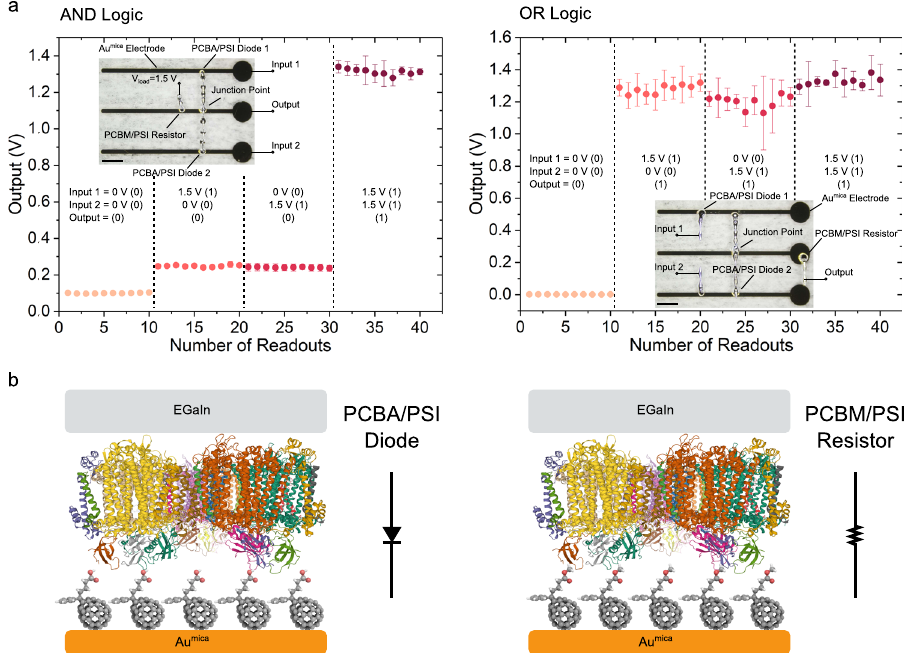
Fig. 5 Characterization of the functions of logic circuits comprising Au mica /PCBA//PSI//EGaIn junctions and Au mica /PCBM//PSI//EGaIn junctions and printed EGaIn electrodes. a Schematics (inset) and plots of output voltage of AND logic circuits (top) versus varied input under a constant load of 1.5 V and OR logic circuits (bottom) versus varied input. Numbers in brackets represent the input and output values in a truth table. Error bars represent standard deviation of the mean. Scale bars of the insets are 1.5 mm. b Schematics of the diode (left) comprising a Au mica /PCBA//PSI//EGaIn junction and the resistor (right) comprising a Au mica /PCBM//PSI//EGaIn junction used in the logic